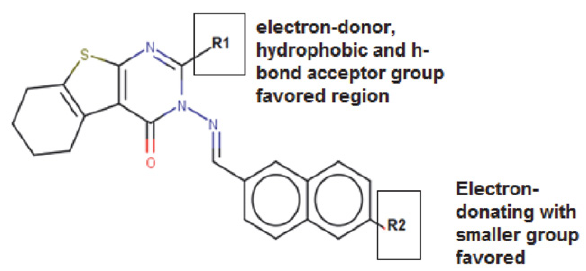
Fig. 9. Structure-activity relationship representation.